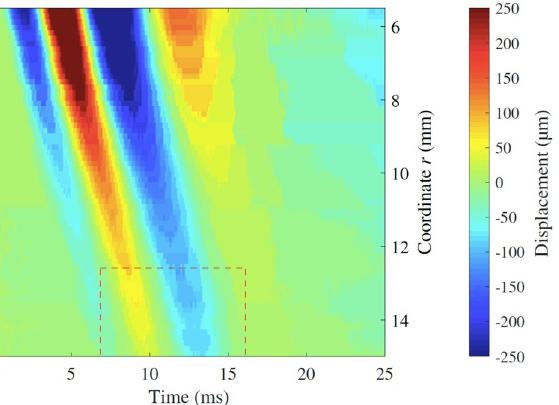
Figure 13. Time-space representation of the particle displacement u θ from a HSC test in phantom 1. Driving signal at 300 Hz. The top side of the figure coincides with the edge of the disk emitter, while the bottom side coincides with the front face of the stiff inclusion.